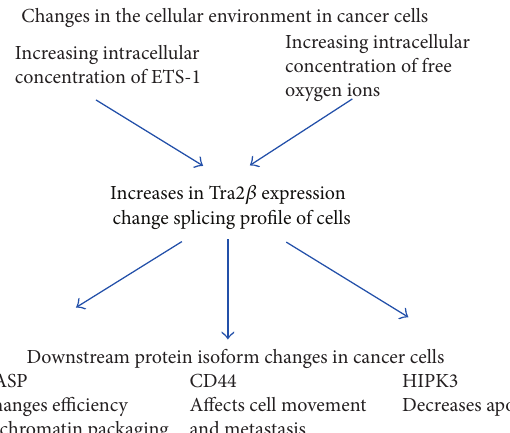
Figure 4: Hypothetical model suggesting how changes in the cellularenvironmentmayinfluencetheexpressionofTra2 𝛽 andlead to downstream changes in mRNA splice isoform